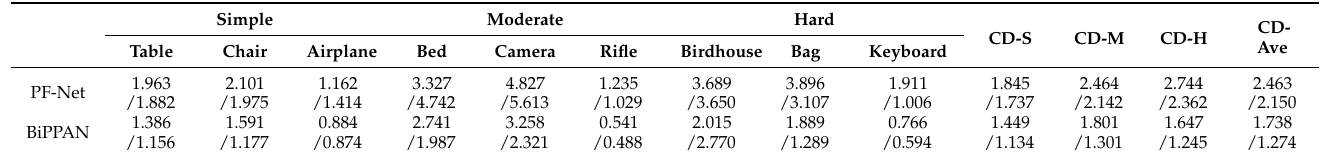
Table 3. Results of a comparison between our method and PF-Net on the ShapeNet-55 dataset. The numbers in pairs are Pred → GT and GT → Pred Chamfer Distance × 10 3 (lower is better). CD-S, CD-M, and CD-H were used to represent CD errors in the simple, moderate, and hard classes.